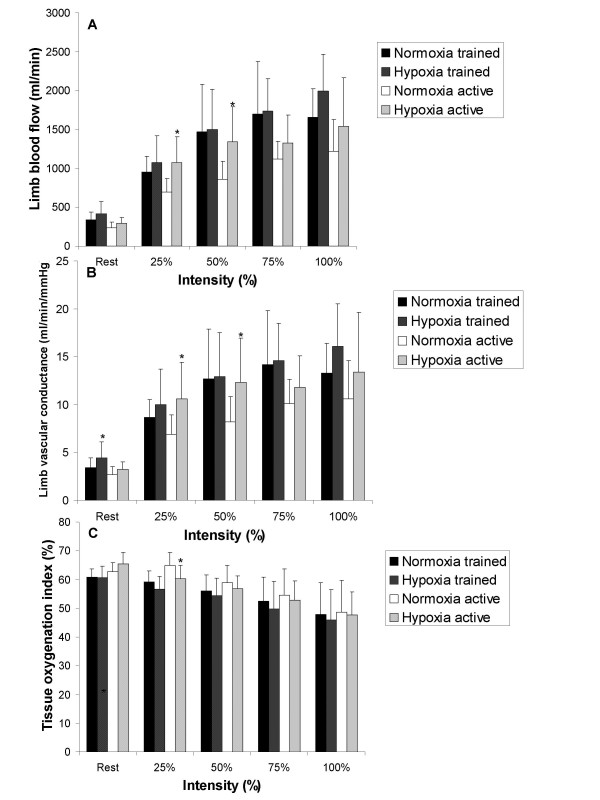
Comparison of limb blood flow (Panel A), limb vascular conductance (Panel B) and tissue oxygenation (Panel C) for trained and active groups during exercise. * means significantly different normoxia (p < 0.05).